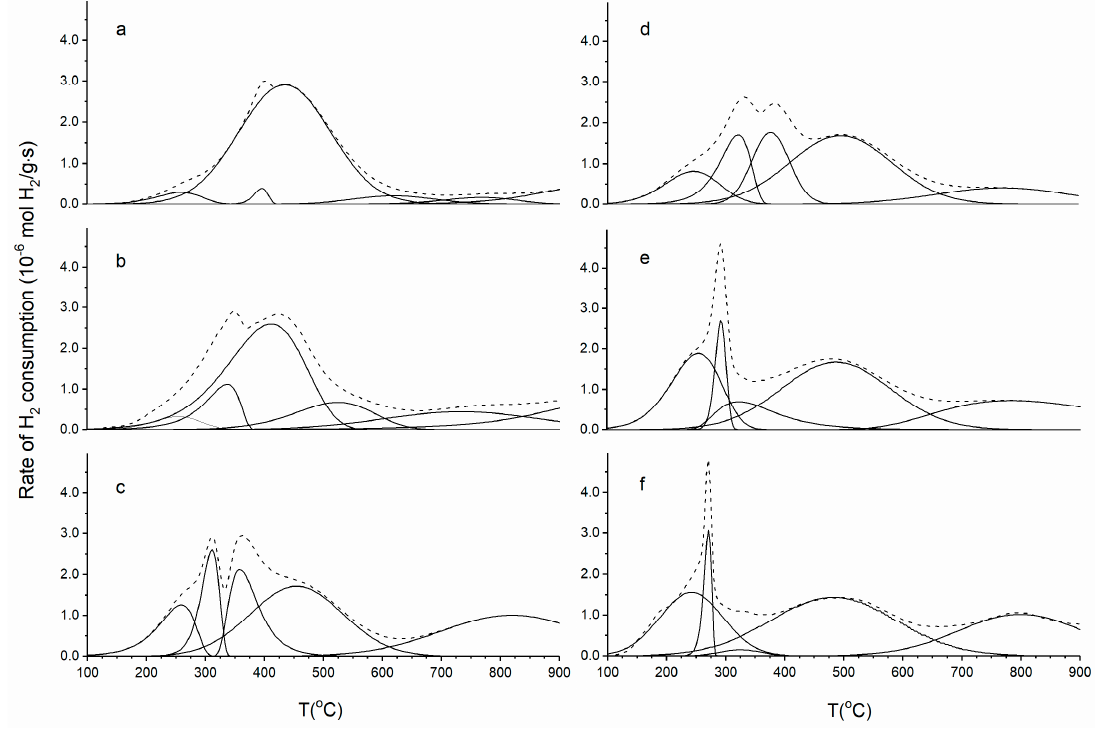
Figure 12. TPR curves of Ni-Ce x Zr 1 − x catalysts: ( a ) Ni-Ce 0.3 Zr 0.7 im; ( b ) Ni-Ce 0.5 Zr 0.5 im; ( c ) Ni-Ce 0.7 Zr 0.3 im; ( d ) Ni-Ce 0.3 Zr 0.7 op; ( e ) Ni-Ce 0.5 Zr 0.5 op; ( f ) Ni-Ce 0.7 Zr 0.3 op.